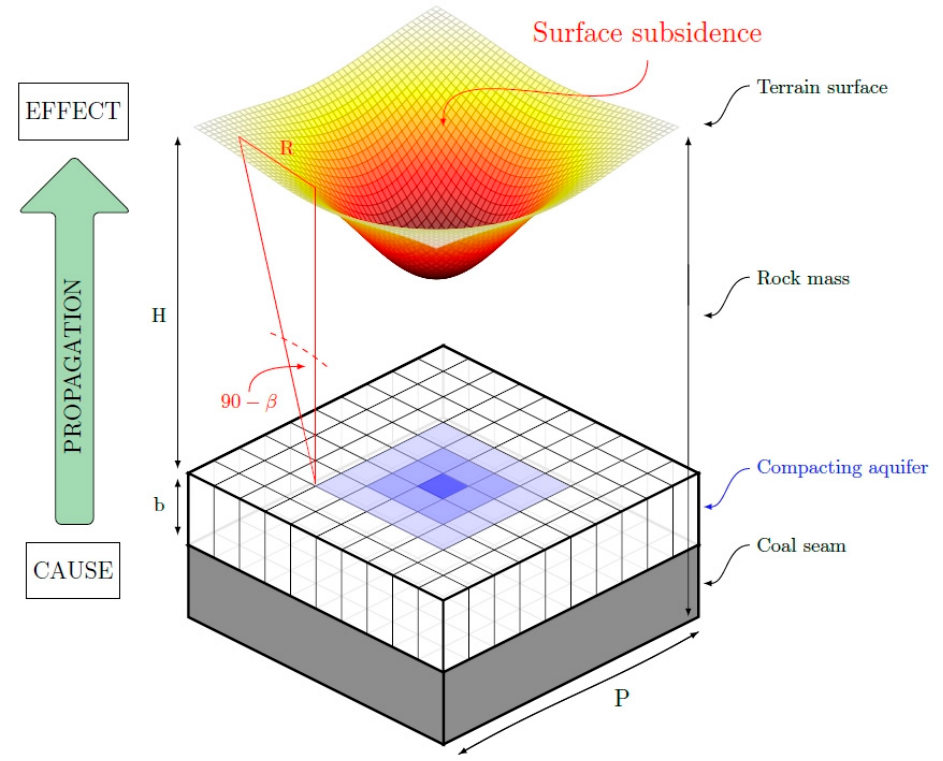
Figure 7. 3-D discretization of the mining drainage-related land subsidence influence function model of the Bogdanka